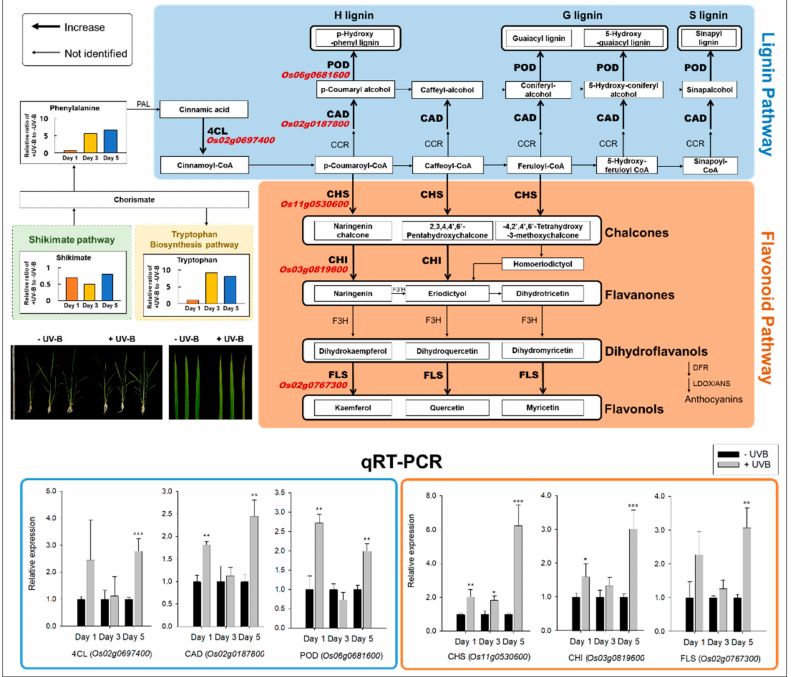
Figure 4. Variations of the key genes and metabolites employed in the metabolic process from phenylalanine to lignin and flavonoid biosynthesis. The bold black arrows indicate the genes that were upregulated in leaf blades under +UVB. Six genes were validated by qRT-PCR (mean ± SD, n = 6), and the bars in black and grey indicate − UVB and +UVB, respectively. Note: *, **, and *** mean p < 0.05, 0.01, and 0.001 (Student’s t -test) for qRT-PCR, respectively. Actin was used as the